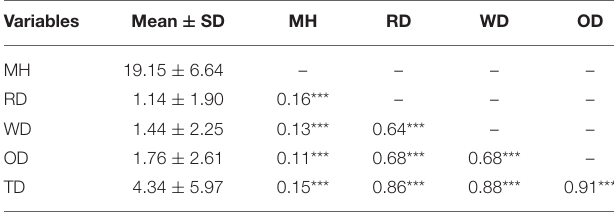
TABLE 2 | Correlation coefficient matrix for parental parenting style disparities and mental